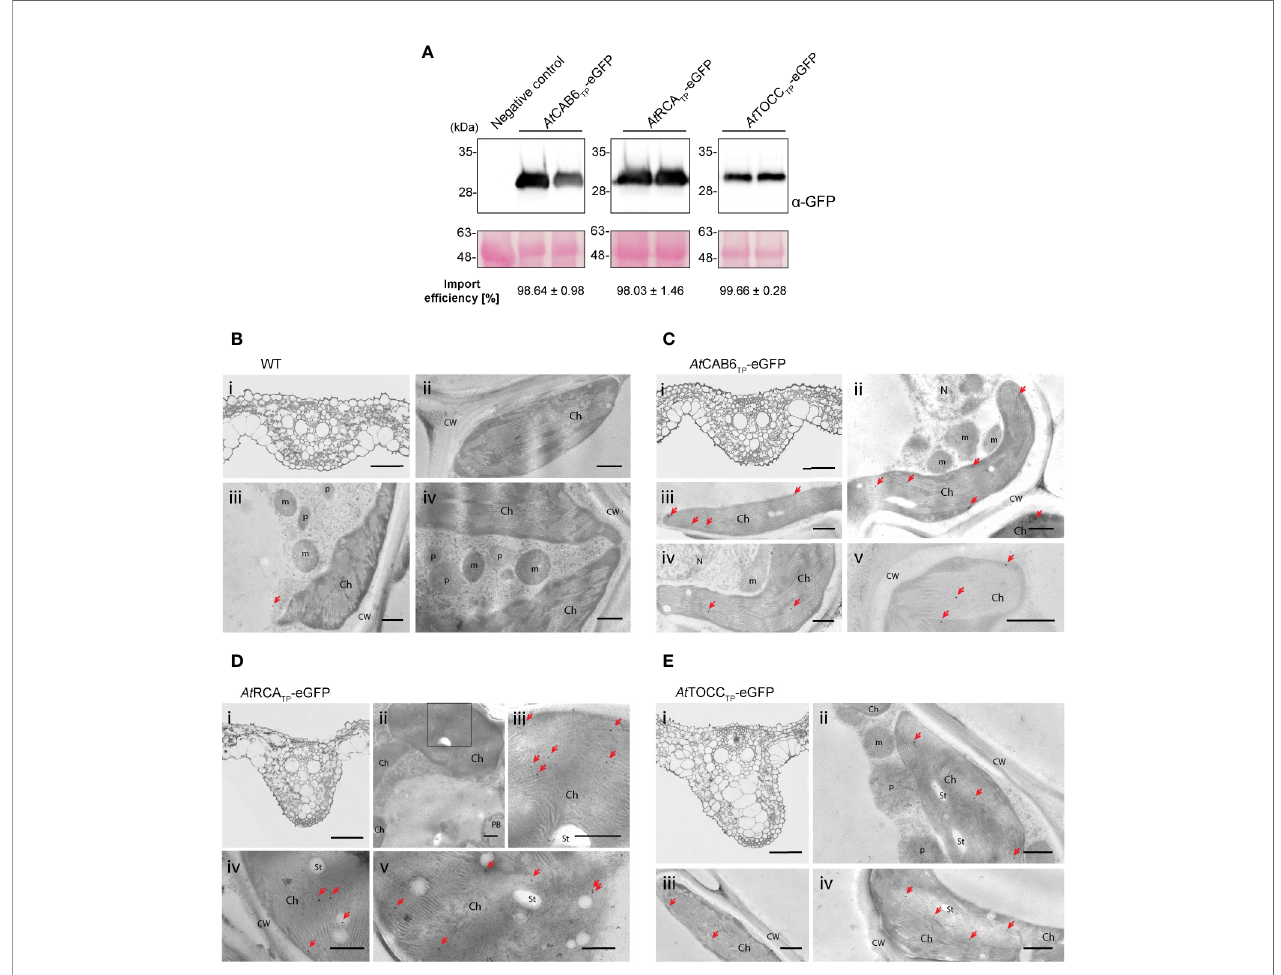
FIGURE 5 | Regenerated rice plants show eGFP targeting into chloroplast driven by Arabidopsis transit peptides (TPs). (A) Western blot analysis of leaf total protein extracts from two plants regenerated from the same transformed callus line expressing the indicated constructs above, incubated with anti-GFP antibody. Negative Control represents a wild-type plant. Import ef fi ciency was de fi ned as the percentage of the processed faster-migrating protein form relative to the total amount of expressed eGFP protein. Data shown are means ± SD of three independent extractions. (B-E) Immunogold labeling of eGFP in chloroplast of rice leaf cells using a GFP-speci fi c monoclonal antibody (diluted 1:250). (B) Wild-type cells. (C) At CAB6 TP -eGFP. (D) At RCA TP -eGFP. (E) At TOCC TP -eGFP. i: Light microscopy (LM) image of studied section; ii – v: Transmission electron microscope (TEM) images. (Ch, chloroplast; CW, cell wall; m, mitochondria; N, nucleus; p, plastid like organelle; St, starch; bars i = 50 µm, ii-v = 500 nm; gold particle size = 15